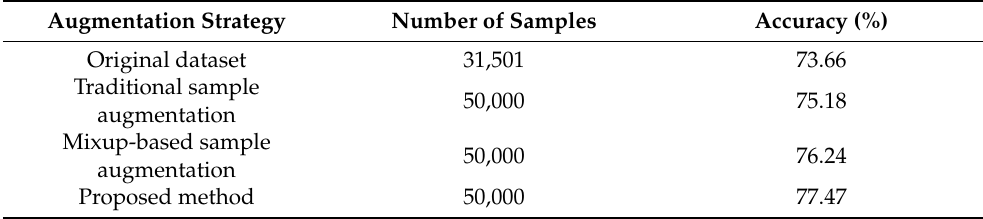
Table 5. Influence of sample augmentation strategy on forest fire identification accuracy.